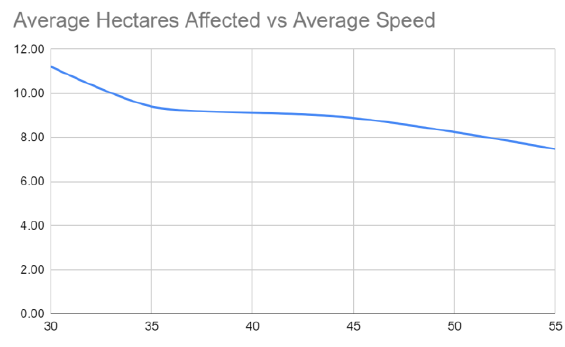
Figure 9 . Graph of Average Hectares Affected for simulations done at 70% density with speeds between 30 and 55 km/h.